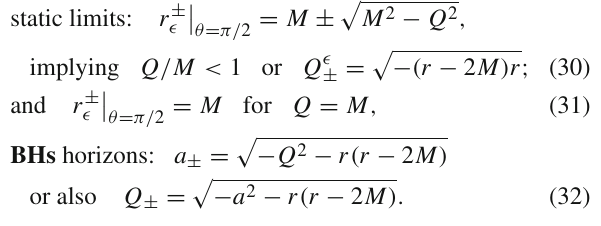
(gray). Right panel: 3 D plot of the frequencies ω ± dimensionless spin a / M and charge Q / M (purple), ω + H H